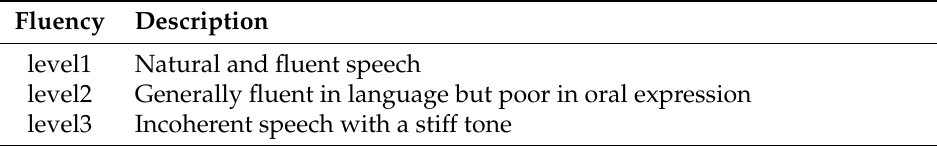
Table 1. Manual scoring metrics of fluency on the PSCPSF.